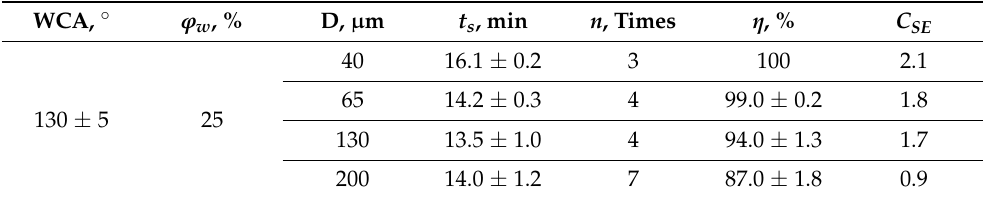
Table 3. Efficiency coefficient for the separation of emulsions with a water concentration of 25% for different pore sizes of a hydrophobic